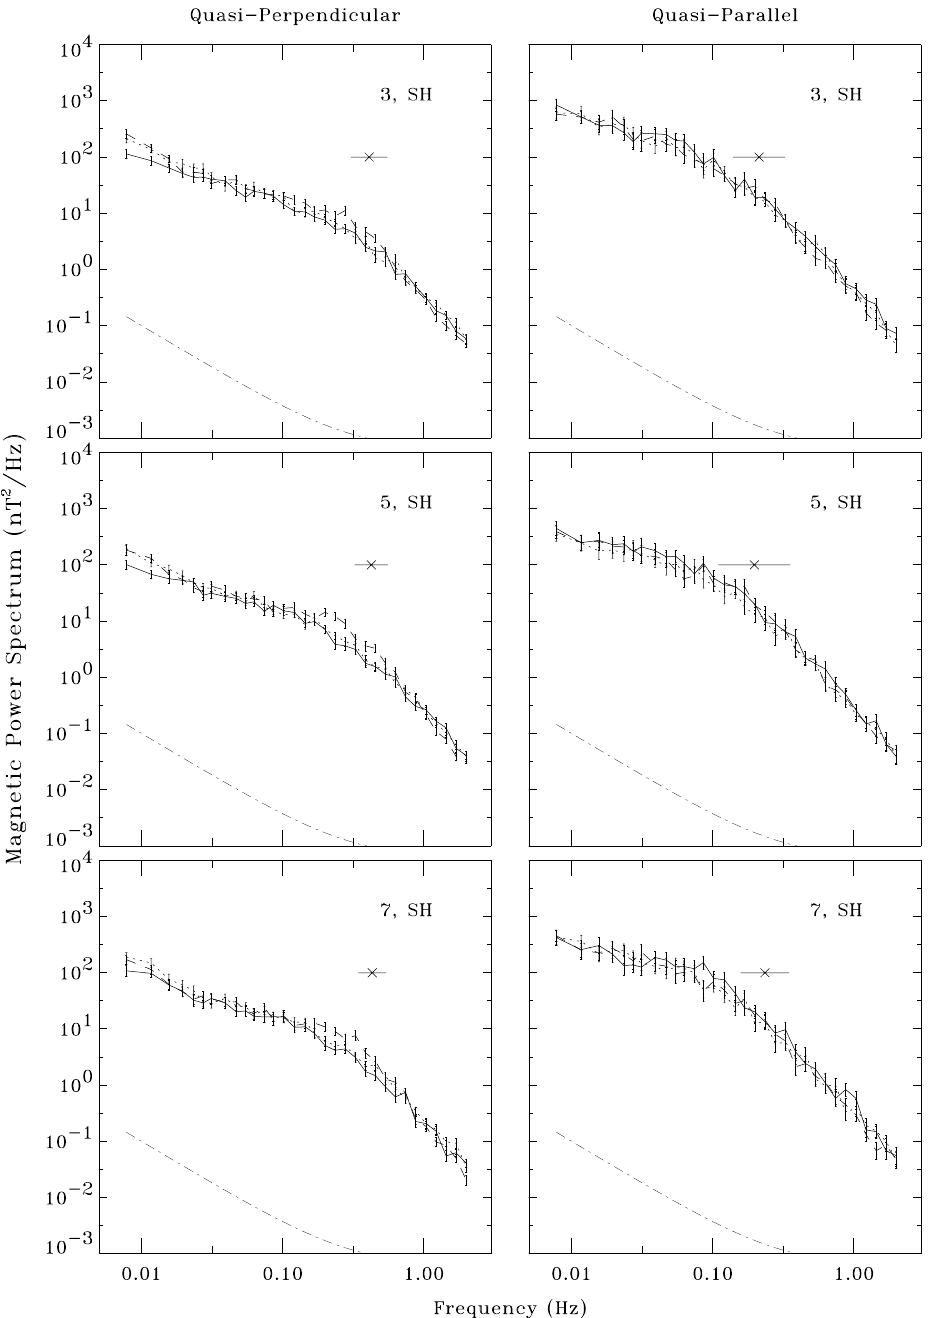
Fig. 3. Superposed-epoch analysis of magnetic spectra of 92 quasi-perpendicular (left) and 40 quasi-parallel bow shock crossings (right) from 3min to 7min downstream. Same format as Fig.